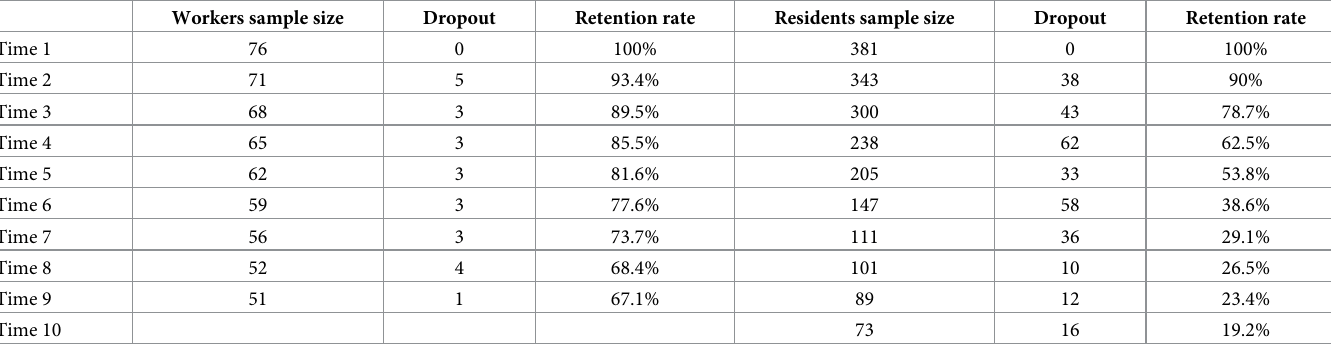
Table 1. Total response rate across the measurement time points for child care workers and residents in the study.